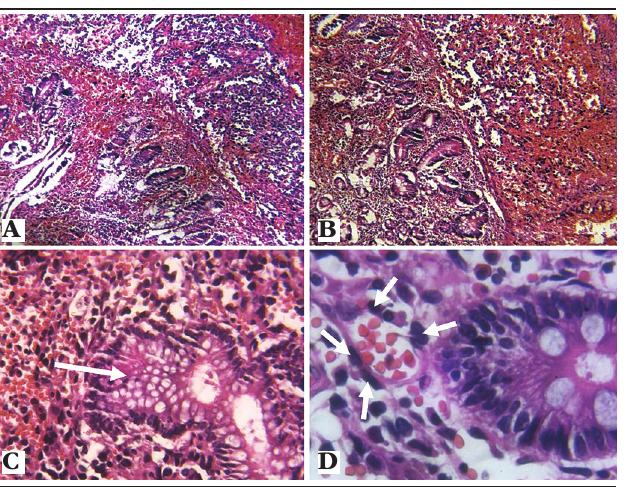
figurE 2 − Histological sections of intestinal tissue observed through an optical microscope: A and B) on the left, normal intestinal tissue. In contrast, on the right, malignant mesenchymal neoplasm composed of anastomosing vascular channels lined by atypical cells and mitotic figures (HE, 100×); C) intestinal crypt (arrow), surrounded by neoplastic tissue of vascular origin (HE, 400×); D) malformed vascular channel containing erythrocytes, composed of pleomorphic cells (arrows), beside intestinal tissue of normal histology (HE, 1,000×) HE: hematoxylin and eosin.